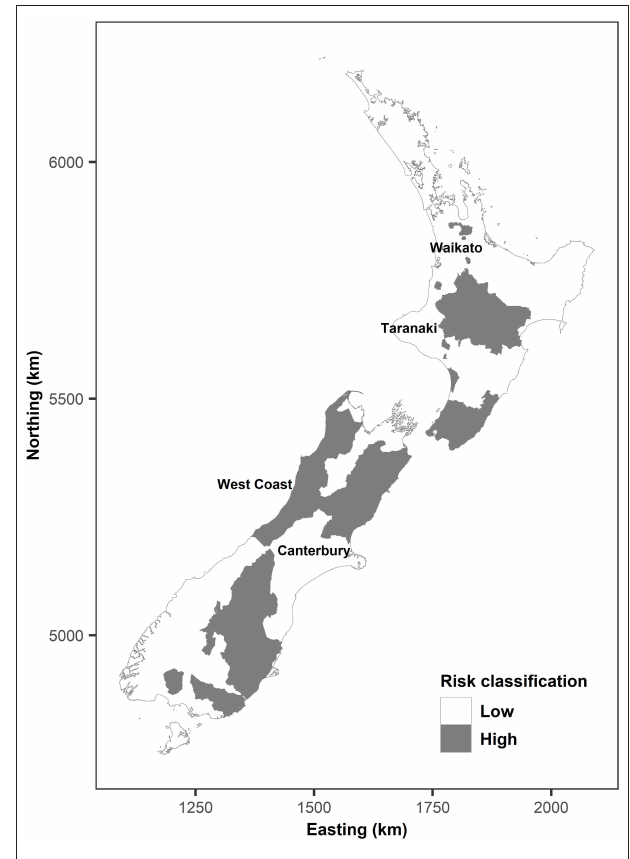
FIGURE 2 | Locations of regions from which interviewed farms were selected in relation to bTB risk. Note the current high bTB risk area as of 2019 is smaller than shown in this